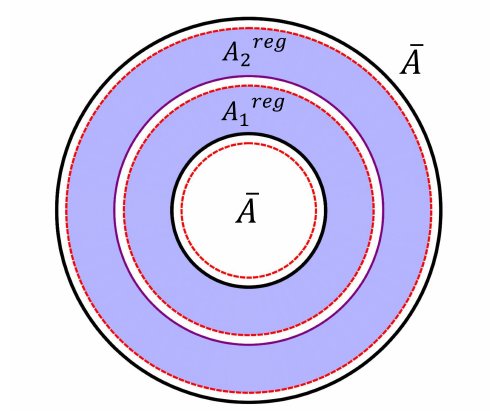
∪ A with rotation symmetry. The white 1 2